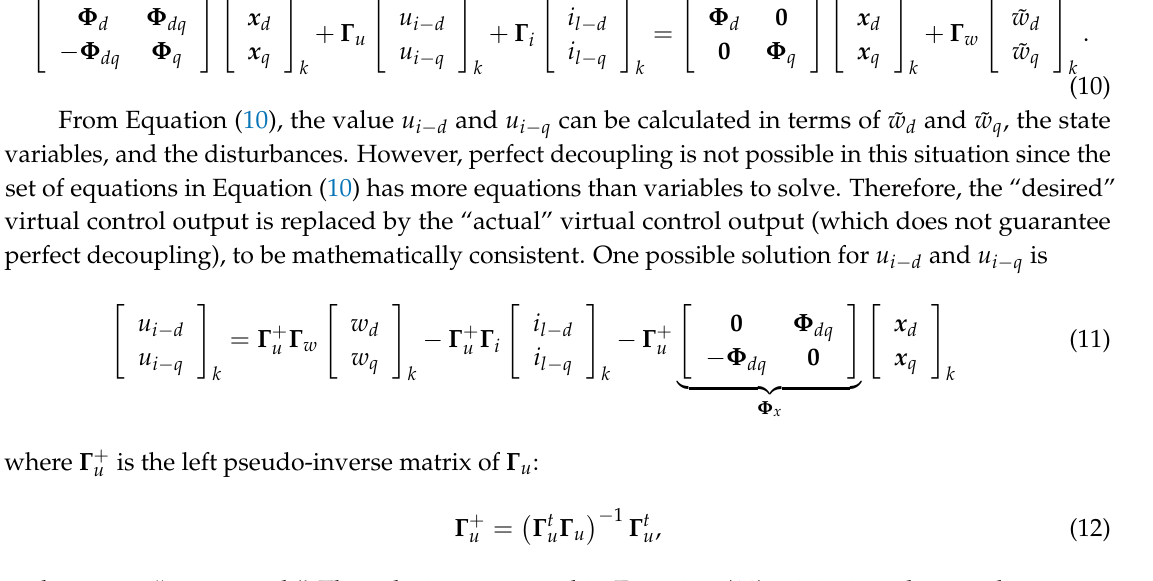
and t means “transposed.” The solution presented in Equation (11) minimizes the coupling terms between the dq -axis dynamics because it is obtained by using the pseudo-inverse matrix, and this provides the least-squares solution of Equation